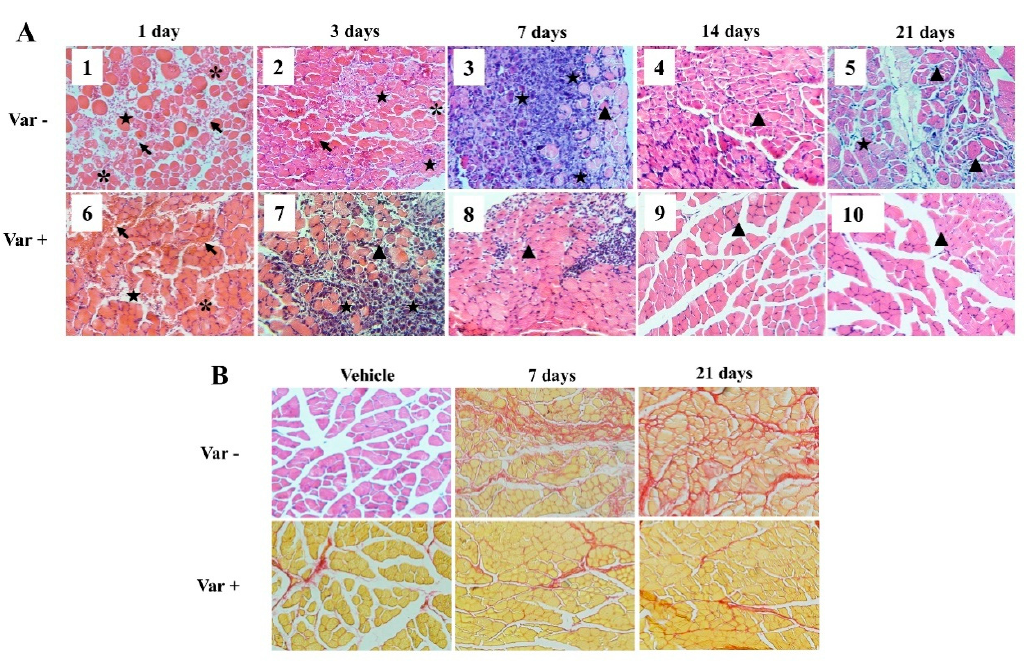
Figure 3. Histological examination of gastrocnemius muscle during necrosis and repair. ( A ) Histological examination of gastrocnemius muscle during necrosis and Hematoxylin-eosin (HE) staining of the gastrocnemius muscle. Photos of day 1 to day 3 were characterized by severe myonecrosis (asterisk), massive erythrocytes (arrow) and inflammatory cell